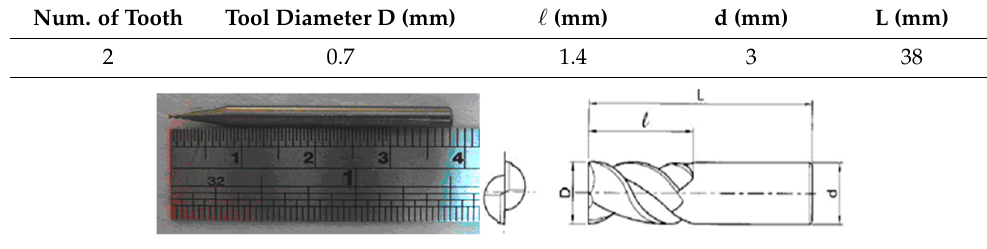
Table 2. Composition of SK2 workpiece.